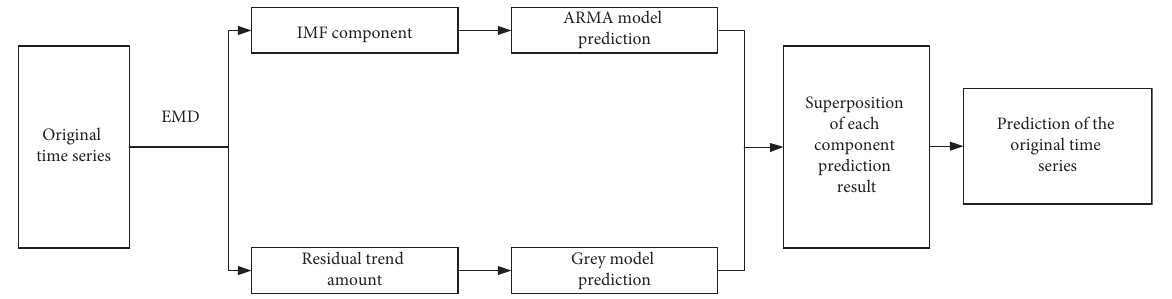
Figure 1: The EMD-GM-ARMA modeling schematic